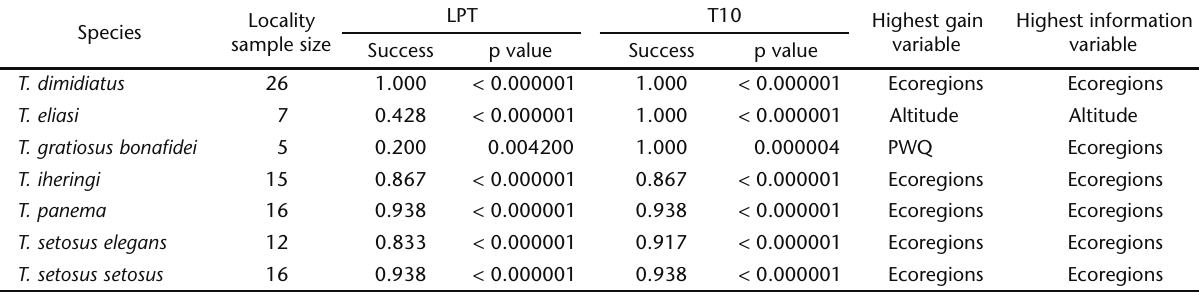
Table II. Jackknife tests of distribution models for six Trinomys species. (LPT) Lowest presence threshold, (T10) withdrawing 10% of the lowest prediction values, (PWQ) Precipitation of Warmest Quarter.